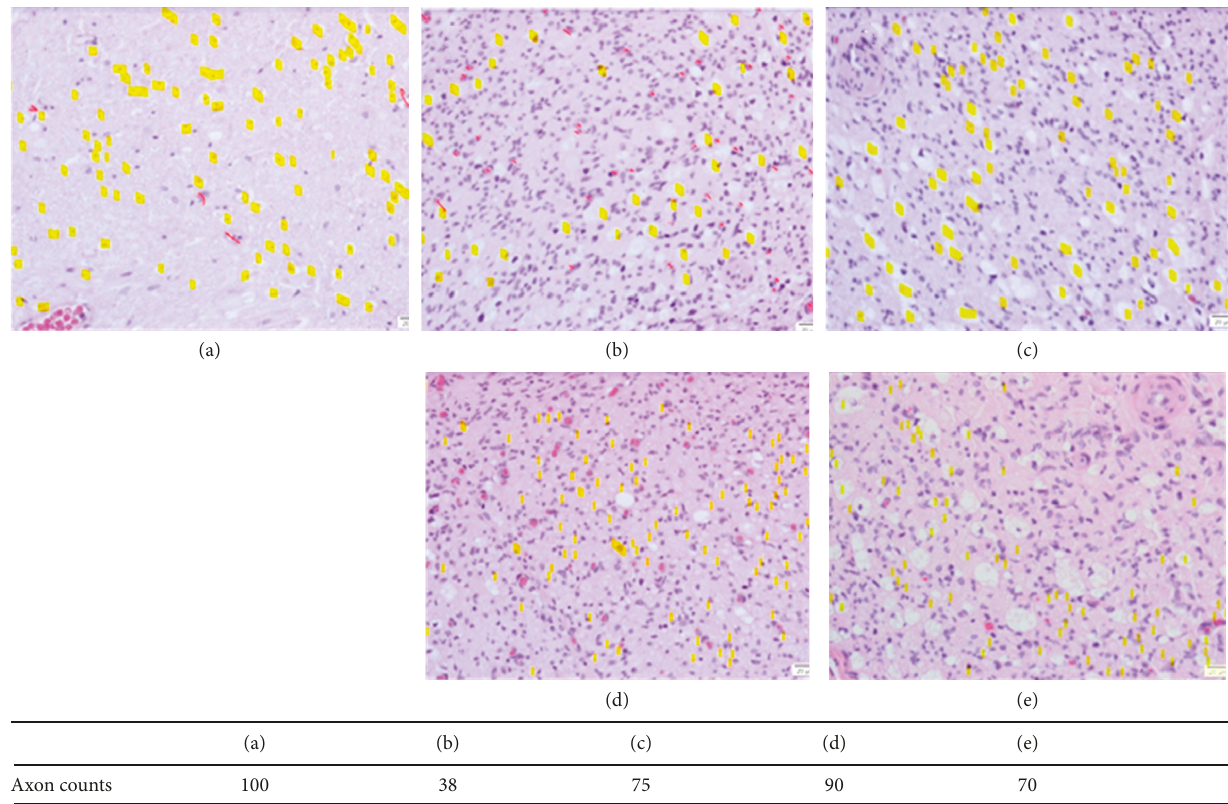
Figure 5: H&E staining of sciatic nerves in different groups at 6 weeks post nerve injury. The number of axons (yellow marks) was counted in a representative high-power field of the transverse section ( × 1000). (a) Group 1: surgical incision without nerve injury. (b) Group 2: nerve injury with normal saline injection. (c–e) Group 3: nerve injury with 0.5, 6, and 20 μ g · kg − 1 DXM injection (groups 3A, 3B, and 3C,